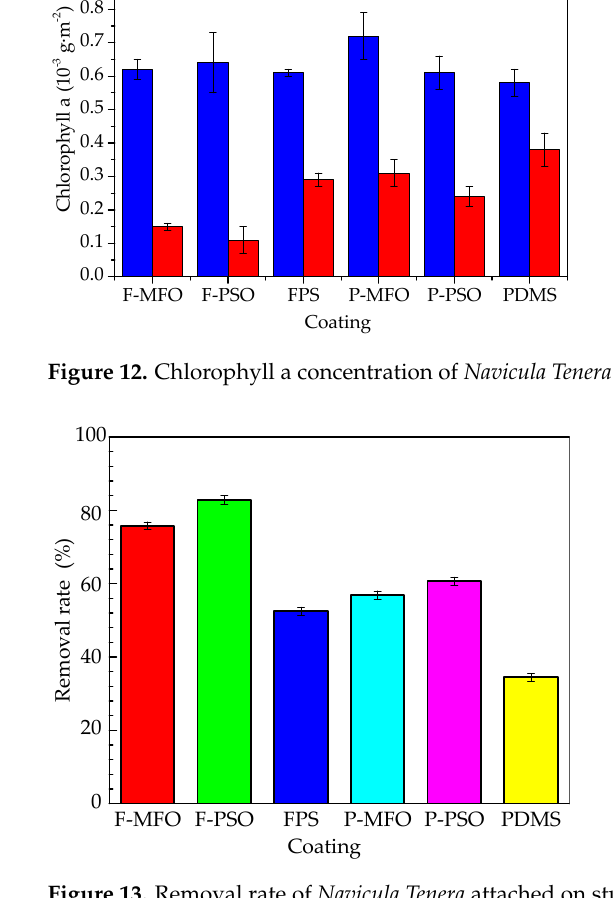
Figure 13. Removal rate of Navicula Tenera attached on studied coatings.